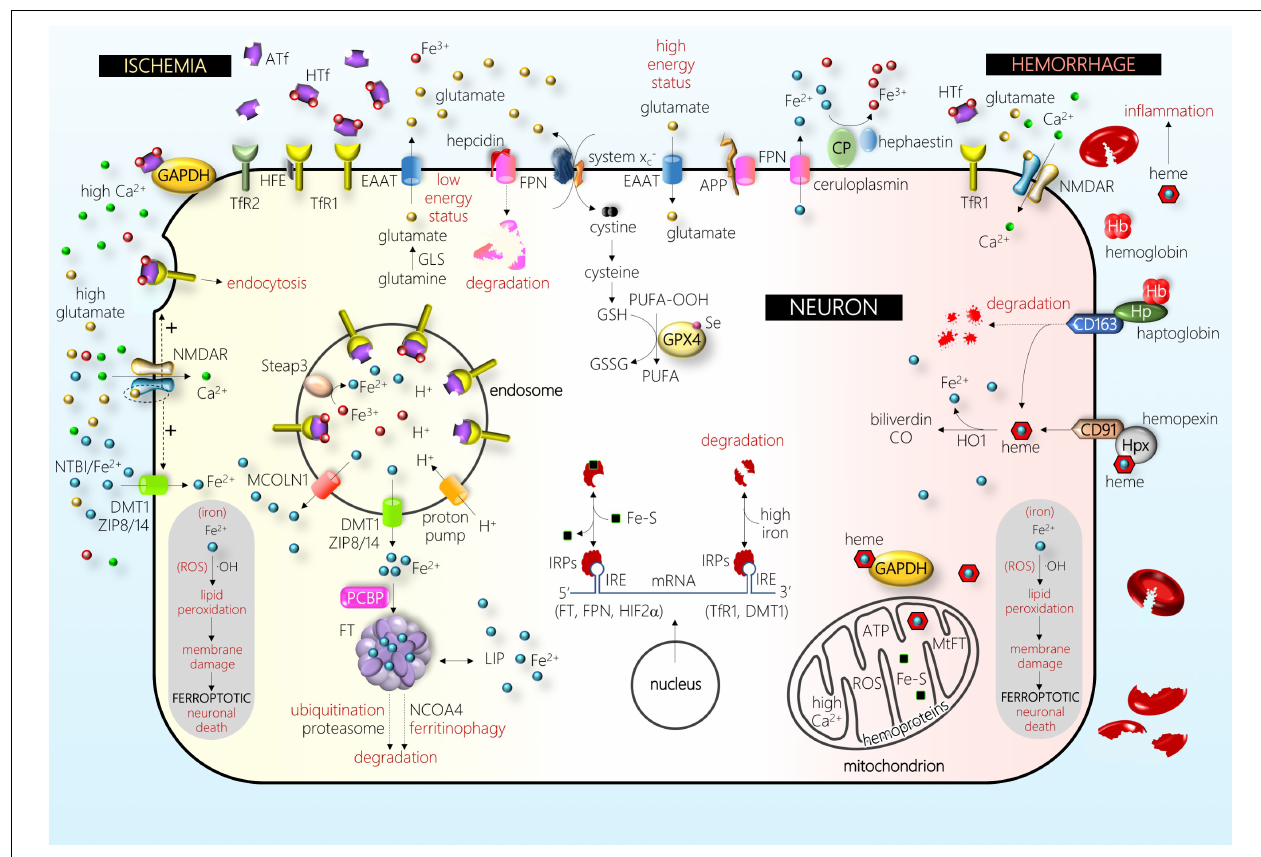
FIGURE 2 | Schematic drawing of some of the main players in a neuron under ischemic (left-hand side) and hemorrhagic (right-hand side) stress (see text for details). Abbreviations: APP, amyloid precursor protein; ATf, apotransferrin; CD163, hemoglobin/haptoglobin receptor; CD91, heme/hemopexin receptor; CO, carbon monoxide; CP, ceruloplasmin; DMT1, divalent metal transporter 1; EAAT, excitatory amino acid transporter; Fe 2 + , ferrous iron; Fe 3 + , ferric iron; Fe–S, iron–sulfur cluster; FPN, ferroportin; FT, ferritin; GAPDH, glyceraldehyde-3-phosphate dehydrogenase; GLS, glutaminase; GPX4, glutathione peroxidase 4; GSH, glutathione; GSSG, glutathione disulfide; Hb, hemoglobin; HFE, hereditary hemochromatosis protein; HIF, hypoxia-inducible factor; HO1, heme oxygenase 1; Hp, haptoglobin; Hpx, hemopexin; HTf, holotransferrin; IRE, iron-responsive element; IRPs, iron regulatory proteins; LIP, labile iron pool; MCOLN1, mucolipin 1; MtFT, mitochondrial ferritin; NCOA, nuclear receptor coactivator; NMDAR, NMDA receptor; NTBI, non-transferrin-bound iron; OH, hydroxyl radical; PCBP, poly(rC)-binding protein; PUFA, poly-unsaturated fatty acid; PUFA-OOH, PUFA peroxide; ROS, reactive oxygen species; Se, selenium; Steap, six-transmembrane epithelial antigen of prostate; system X − c , cystine–glutamate antiporter; TfR1, transferrin receptor 1; TfR2, transferrin receptor 2; ZIP8/14, zinc transporters 8/14. The picture depicts the effect of one of the major players in the pathophysiology of brain I, the disruption of glutamatergic neurotransmission homeostasis that produces elevated extracellular glutamate levels, overactivation of the NMDA subtype of glutamate receptors (NMDAR), and excitotoxic cell death. In the recent past, different authors have shown that this NMDAR overactivation boosts neuronal iron uptake and produces an iron-dependent form of neuronal death associated with massive